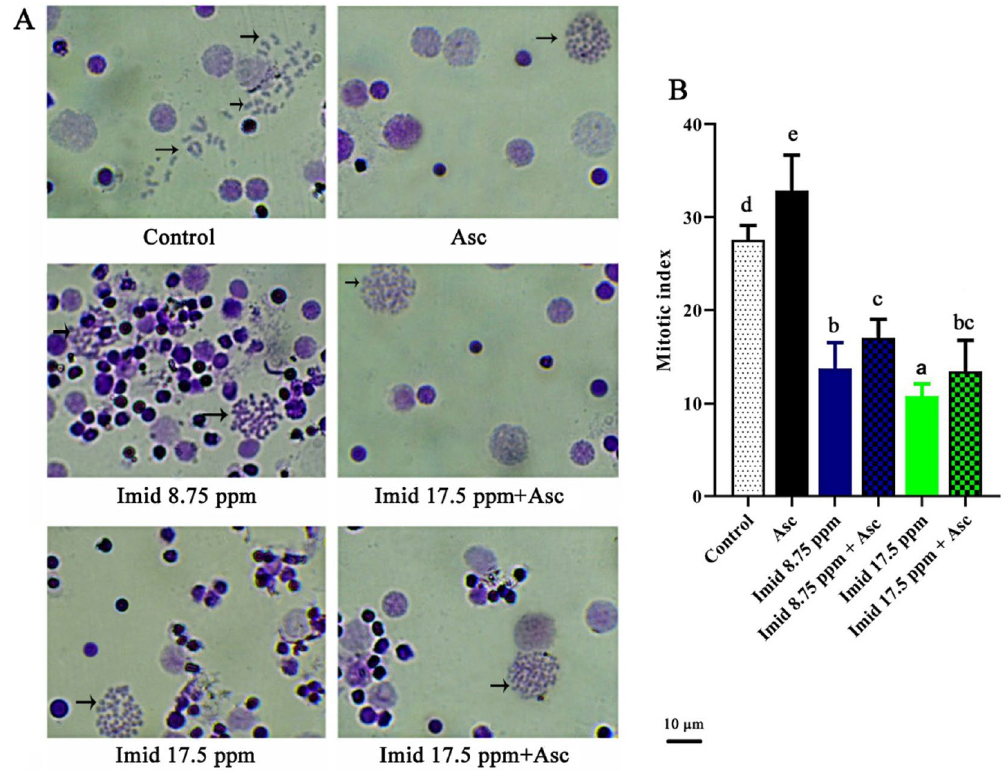
Figure 6. The protective effect of ascorbic acid (Asc, 50 ppm) on the mitotic index changes induced by imidacloprid (Imid) (8.75 and 17.5 ppm) applied for 21 days in O. niloticus . A , representative Representative micro-photographs of studied groups; B , the mean values (M ± SD). Black arrows refer to the mitotic phase. Values were expressed as mean ± standard deviation (SD), bars refer to SD, (n = 5 fish). Different letters above the columns indicate significant differences at p < 0.05 between